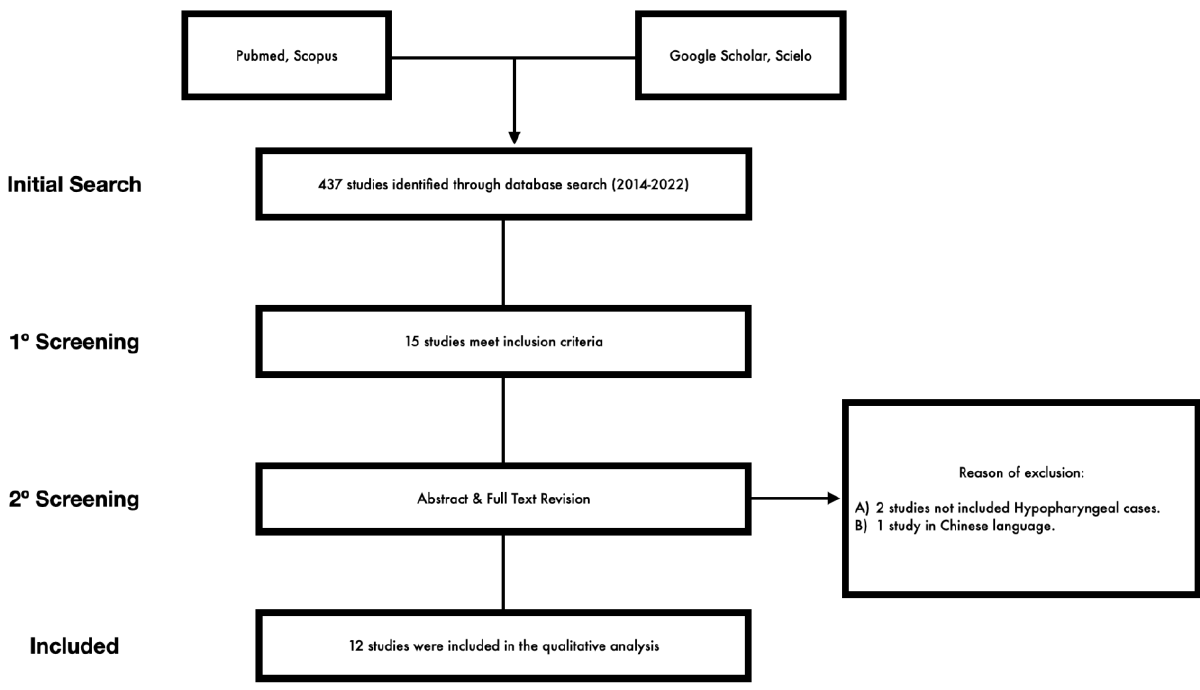
Figure 1. Prisma Figure 1. Prisma flowchart.